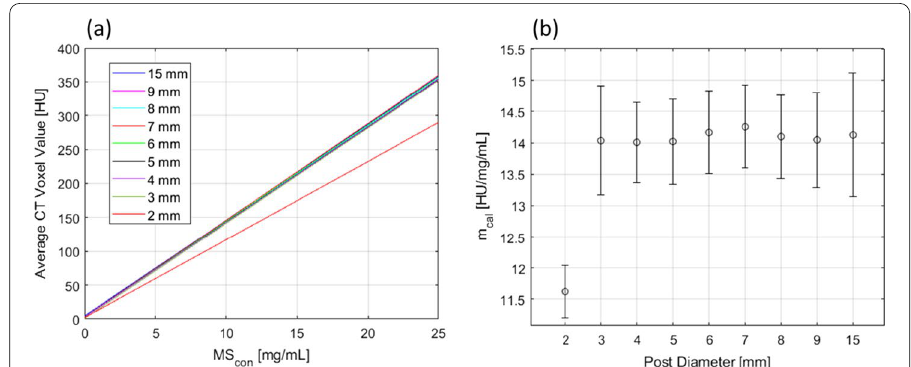
Fig. 5 a Calibration curves derived for all post sizes within the calibration phantom. b Calibration curve slope as a function of post diameter with error bars representing 95% confidence